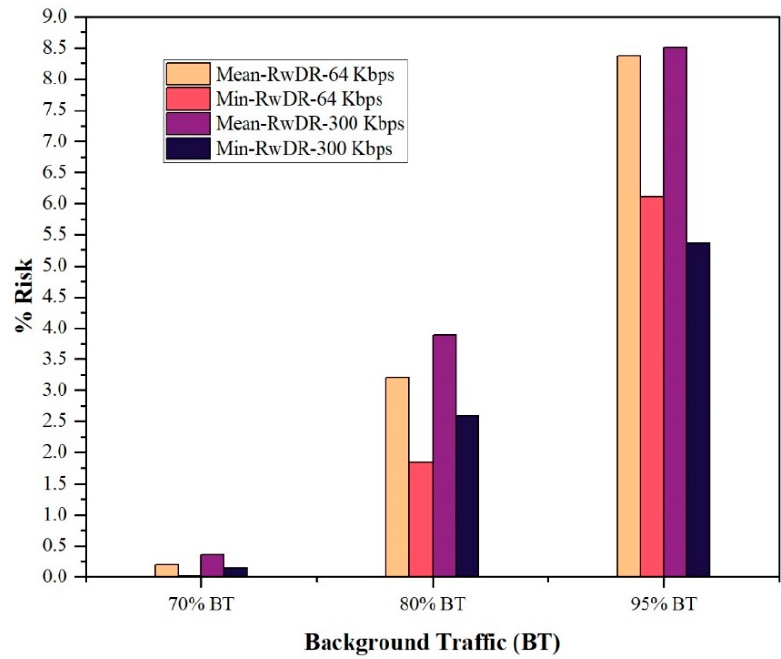
Figure 10. Effect of data rate on risk in hybrid SCN under varying BT.